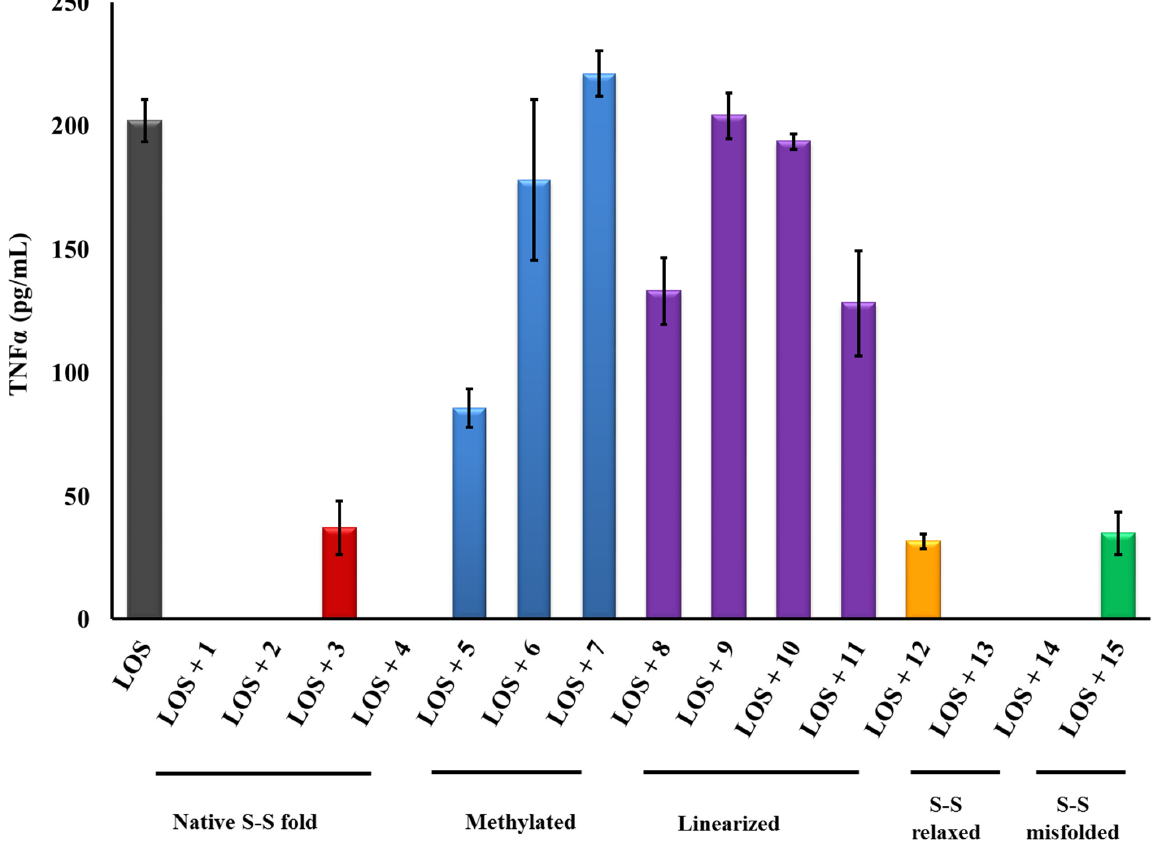
Figure 2. PG-1 analogs neutralized meningococcal LOS activity and inhibited TNF α release. TNF α was released from human macrophage-like THP-1 cells induced overnight with meningococcal LOS (5 ng/mL ~ 2.5 pmole/mL) preincubated with or without 2 µg/mL of PG-1 or its derivatives for 30 min at 37 °C. TNF α release was measured by ELISA. Error bars represent ±SD from the mean of duplicate measurements. This experiment is representative of two independent experiments. Methylated: N-methylated tyrosine or phenylalanine derivatives; S-S: disulfide